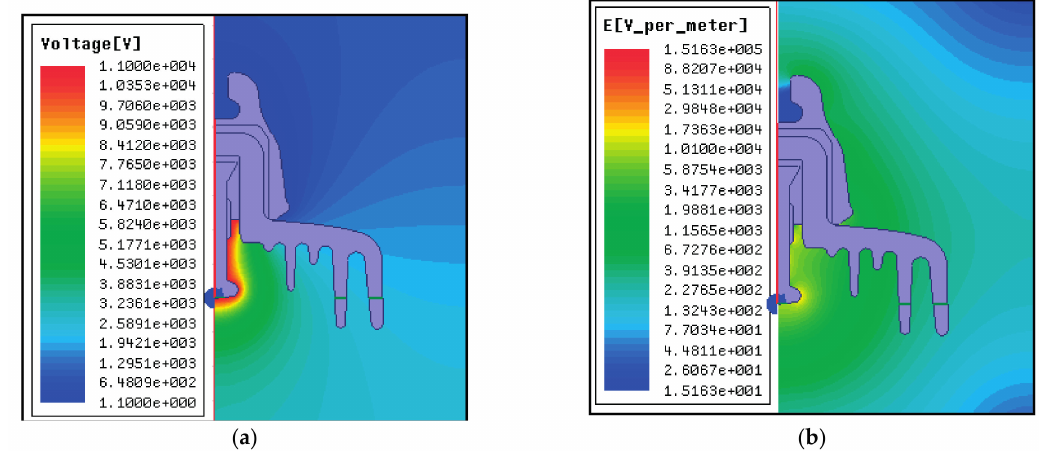
Figure 7. Two-dimensional simulation results of the suspension porcelain insulator. ( a ) The potential distribution of the suspension insulator; ( b ) The electric field of the suspension insulator.